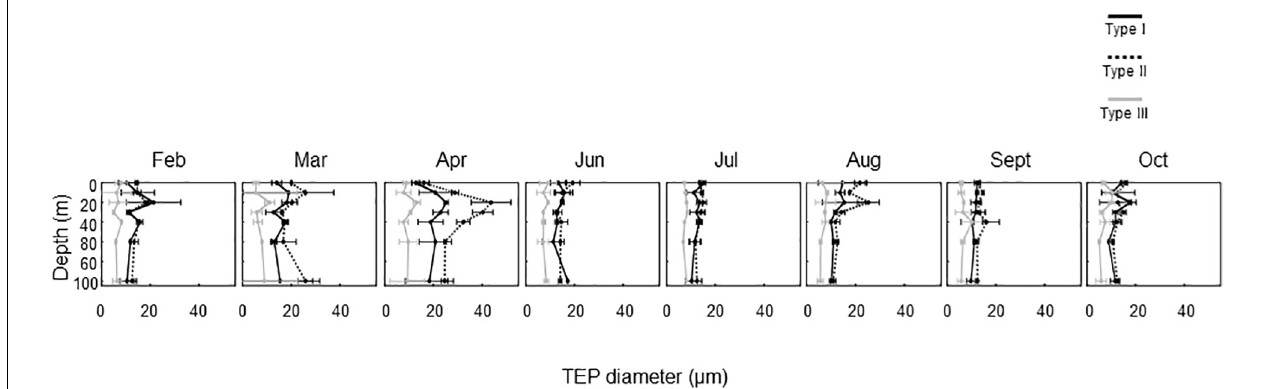
FIGURE 5 | Seasonal changes in vertical distributions of the diameter of transparent exopolymer particle (TEP) types. Errors are ranges of estimates obtained using duplicate microscopic slides ( n = 2).